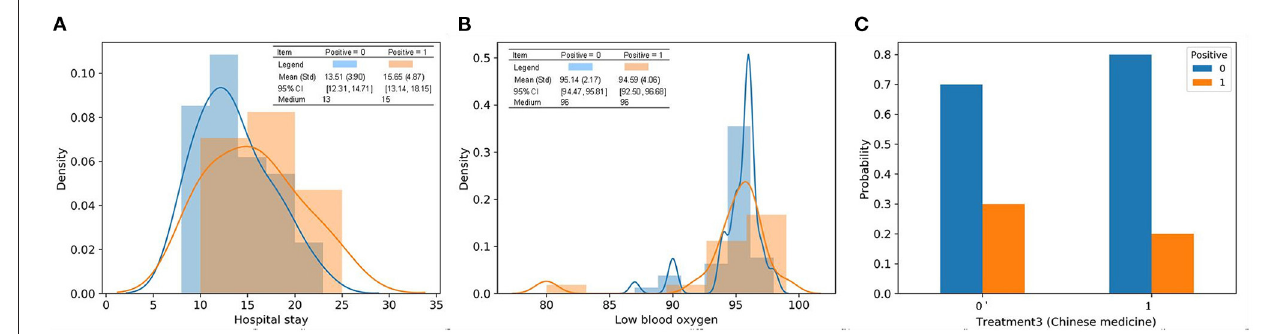
FIGURE 7 | Characteristics of the top three most important features in discharged patients with or without positive RT-PCR after leaving hospital. (A) Patients in positive 1 tend to stay in the hospital for an extra 2 days on average from the distribution; (B) the range of lowest blood oxygen for patients in positive 1 is wider than positive 0; (C) 20% patients using treatment 3 had positive RT-PCR tests, which is 10% less than patients in the group without treatment